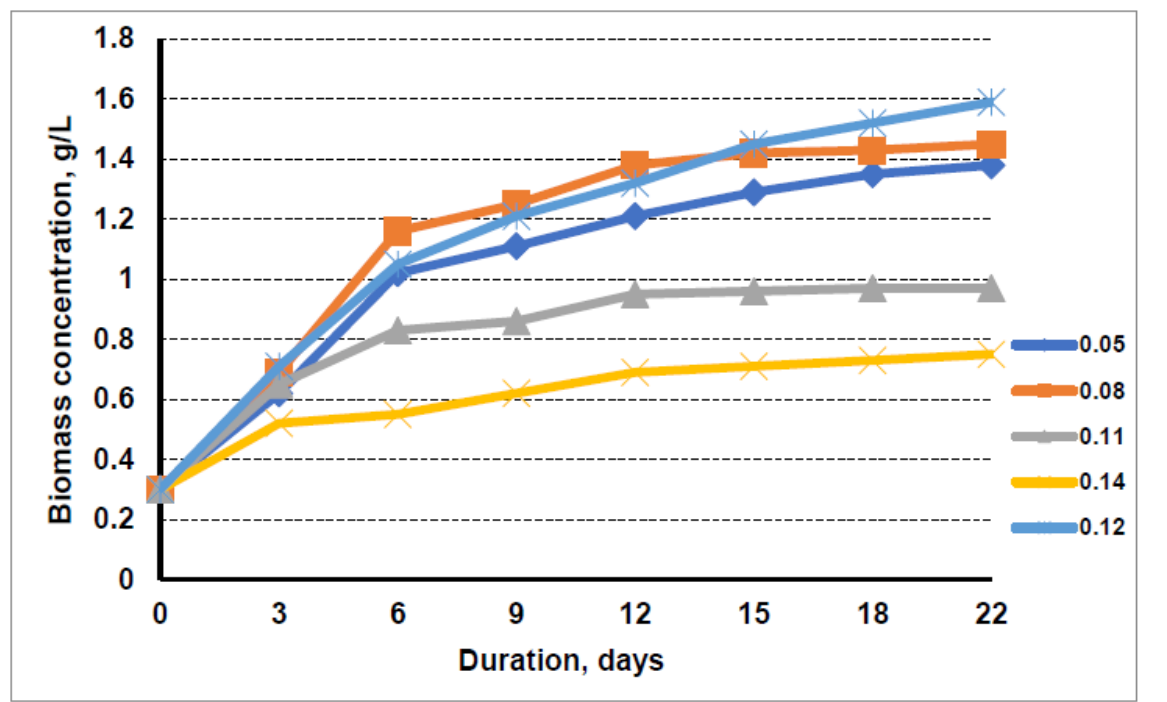
Figure 1. Growth dynamics of microalgae in nutrient medium with the liquid fraction after biogas production from dis- tillers ’ grain at nitrogen concentrations of 0.05 g/L, 0.08 g/L, 0.11 g/L, 0.14 g/L, and 0.12 g/L (control).